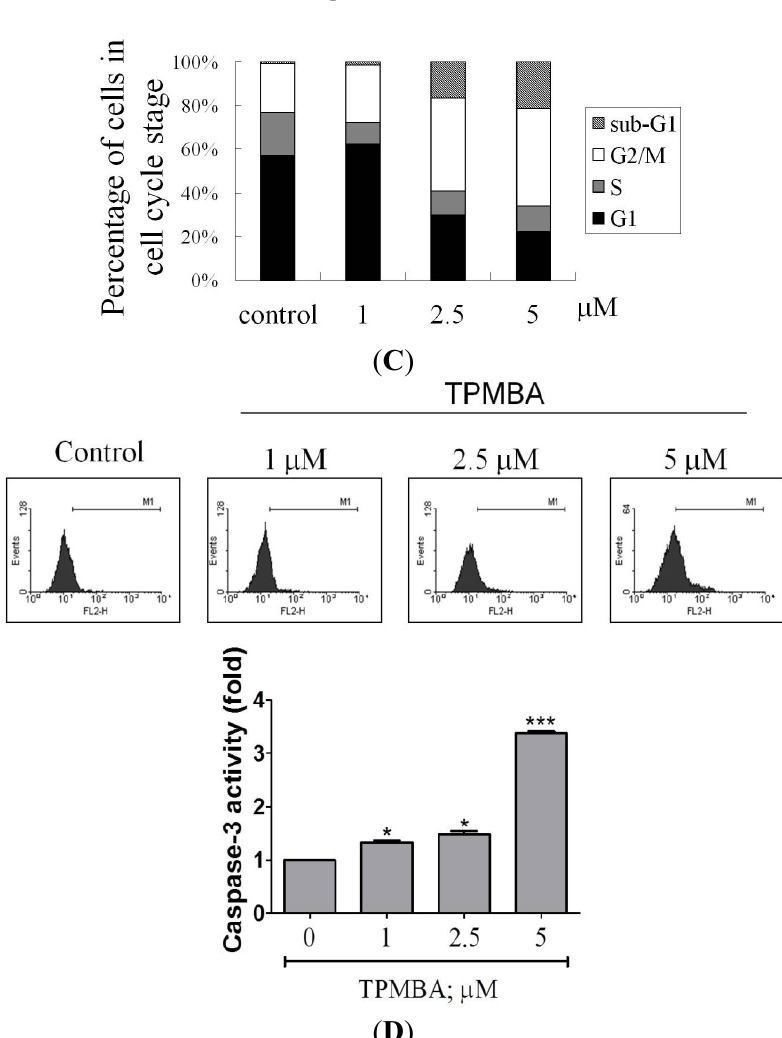
2.3. Induction of Cell Apoptosis and G2/M Cell Cycle Arrest by TMPBA Treatment